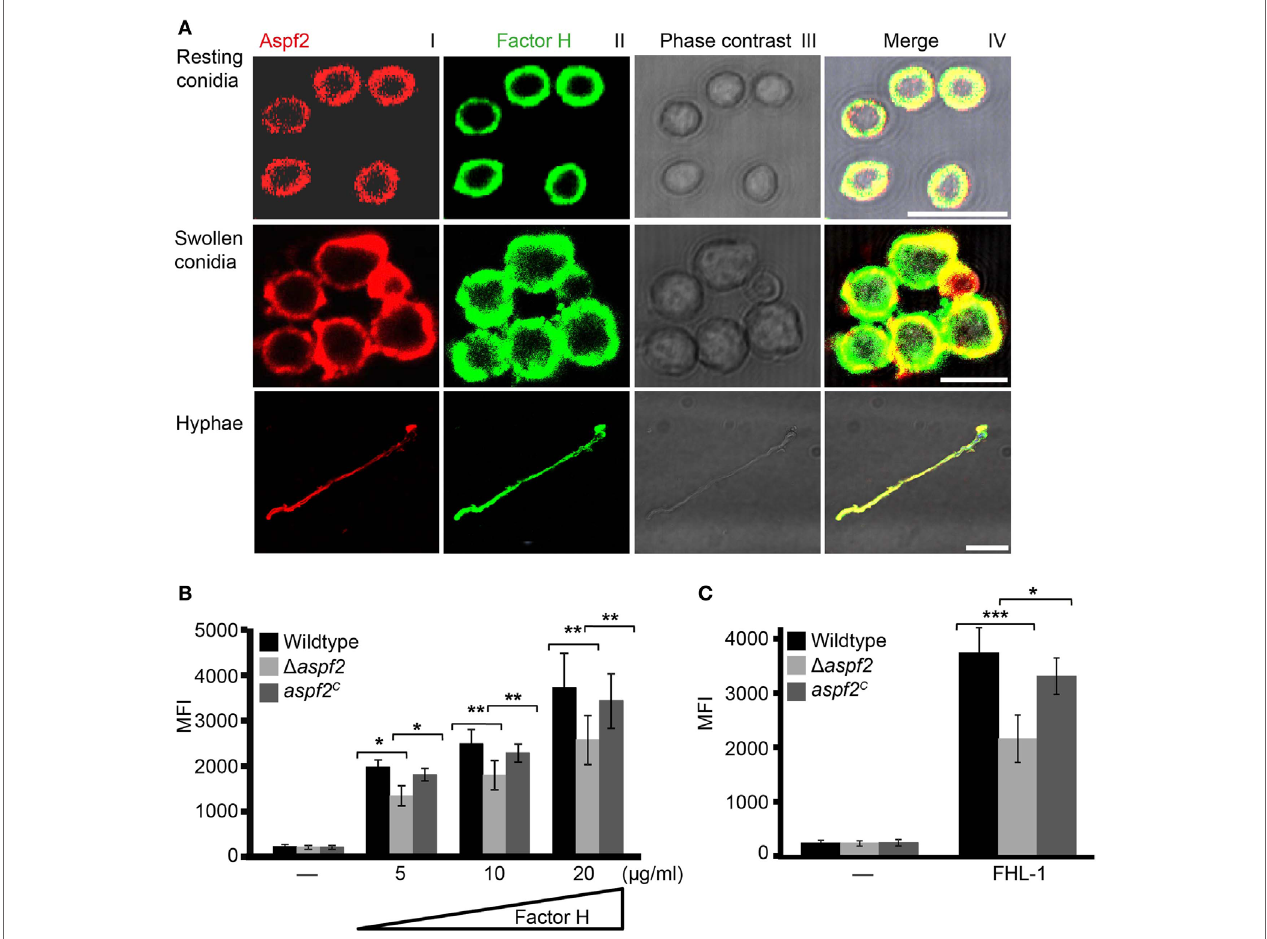
FigUre 4 | Factor H binds to Aspf2 on the surface of Aspergillus fumigatus. (a) Factor H and Aspf2 colocalize on the fungal cell surface. Purified Factor H was added to resting conidia, swollen conidia, and hyphae . After washing, the cells were incubated with anti-human Factor H antiserum and mAb Aspf2, followed by corresponding secondary antibodies. Aspf2 and Factor H were colocalized on the surface of resting (upper panel), swollen conidia (middle panel), and hyphae (lower panel). Scale bars 5, 5, and 20 µm in upper, middle and lower panels, respectively. (B) Δ aspf2 conidia bind less Factor H. Δ aspf2, wild-type, and aspf2 C conidia were incubated with Factor H at the indicated concentrations, and bound Factor H was investigated by flow cytometry. When Factor H was used at 20 µg/ml, the Δ aspf2 conidia bound 28% less Factor H as compared to the wild-type and aspf2 C conidia. (c) The Δ aspf2 strain binds factor-H-like protein 1 (FHL-1) with lower intensity. Purified FHL-1 was bound to Δ aspf2, wild-type, or aspf2 C conidia and bound FHL-1 was analyzed by flow cytometry. When FHL-1 was used at 10 µg/ml , the Δ aspf2 strain bound 42% less FHL-1 as wild-type